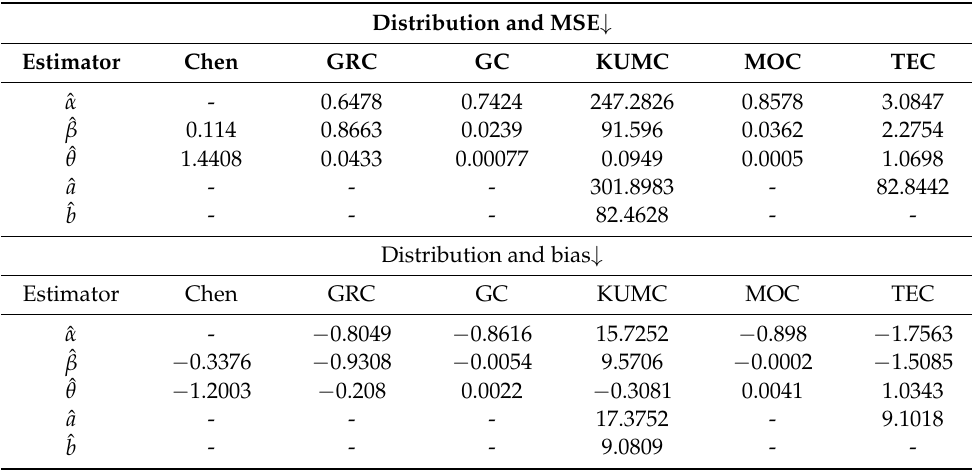
Table 11. Results for samples generated from the Chen distribution with n =